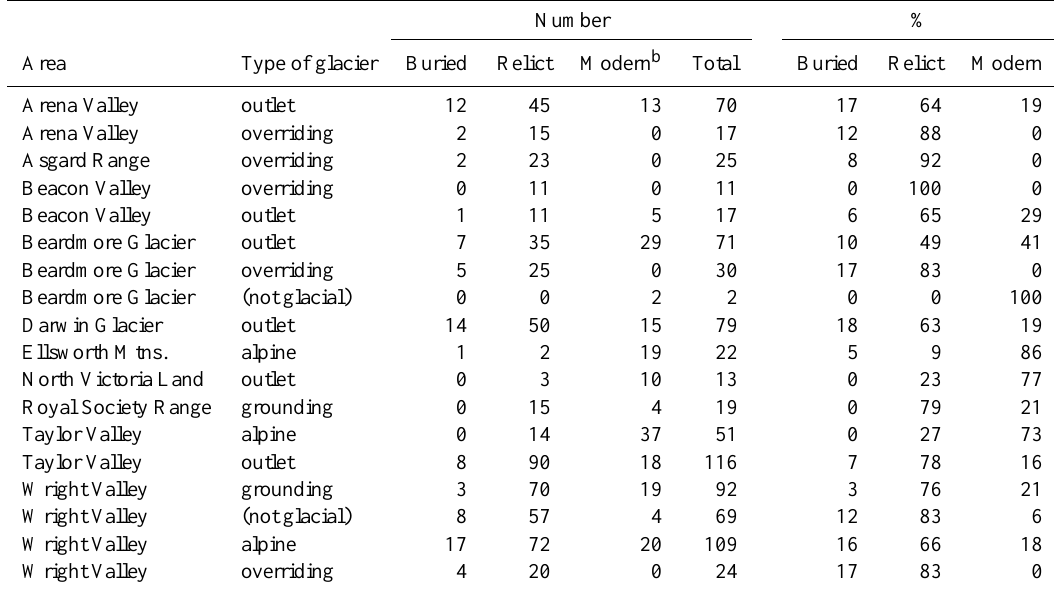
Table 3. Distribution of buried, relict, and modern soils in the Transantarctic Mountains by area and type of glacier a .